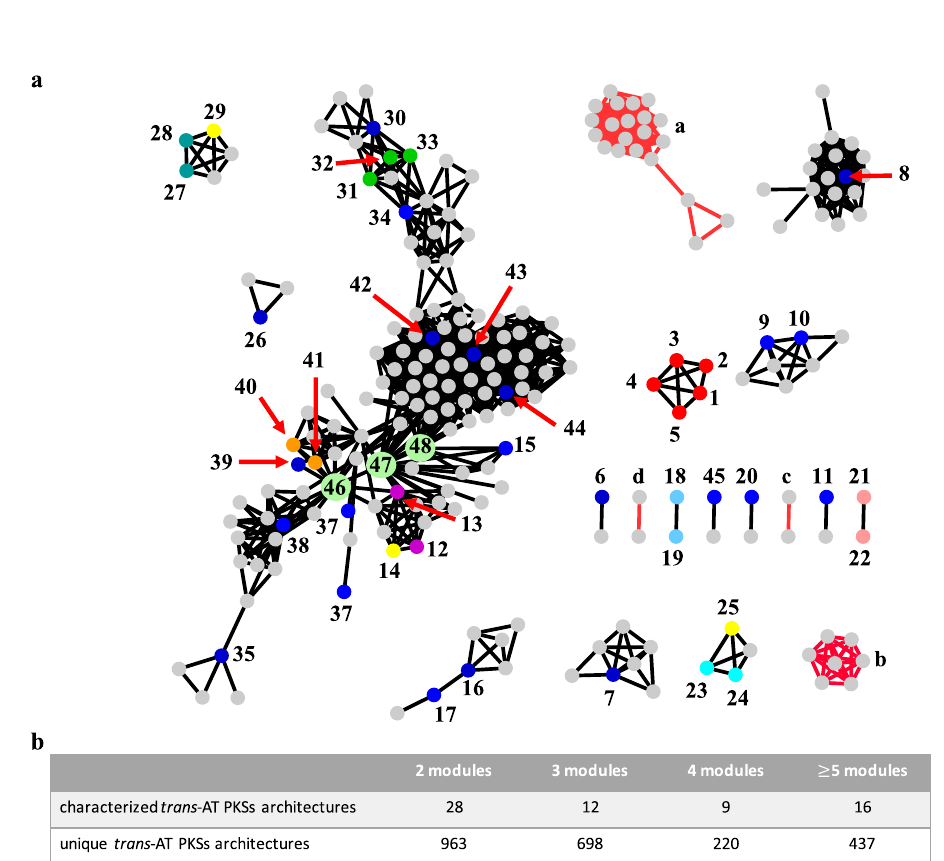
Fig. 2 Conserved PKS module blocks ( ≥ 2 conserved consecutive modules) identi fi ed across all characterized trans -AT PKSs and within the misakinolide, and pederin-type PKS families. a PKS network of all characterized PKSs that share motifs with other characterized PKSs. The edge line width indicates the number of shared modules. PKS families are color-coded as follows: red: pederin-like PKSs, green: misakinolide-like PKSs, light blue: spliceostatin PKSs, violet: glutarimide PKSs, orange: mupirocin/thiomarinol PKSs, blue: corallopyronin/myxopyronin PKSs, rose: chlorotonil/anthracimycin PKSs, and gray: PKSs that do not belong to a characterized trans -AT PKS subfamily. b Evolutionary relationship between misakinolide-like PKSs. Conserved PKS module blocks and the corresponding structural moieties of polyketides are shown in the same colors. Vertical lines represent KSs that cluster together, horizontal lines connect domains of proteins. c Evolutionary relationship between pederin-type PKSs. Gray circles indicate KSs downstream of putative oxygen insertion events. Oxygen insertion, followed by hydrolysis of the formed ester results in a shortened polyketide. An editable Cytoscape network fi le is available as